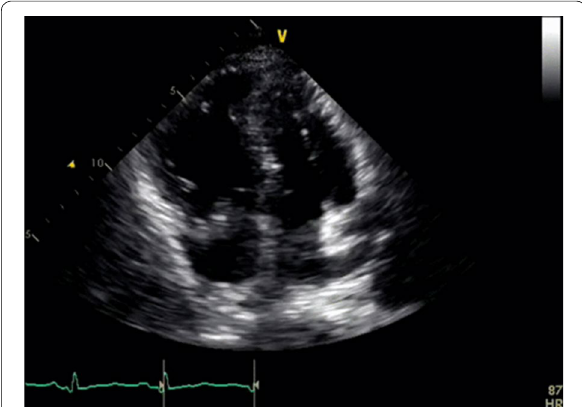
Fig. 1 Apical 4-chamber view with a large mobile thrombus in the right atrium crossing into the right ventricle. The right ventricle is severely enlarged